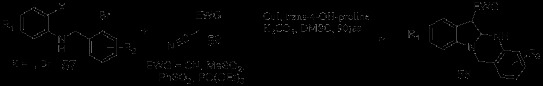
Copper-catalyzed one-pot synthesis of quinazolines derivatives.